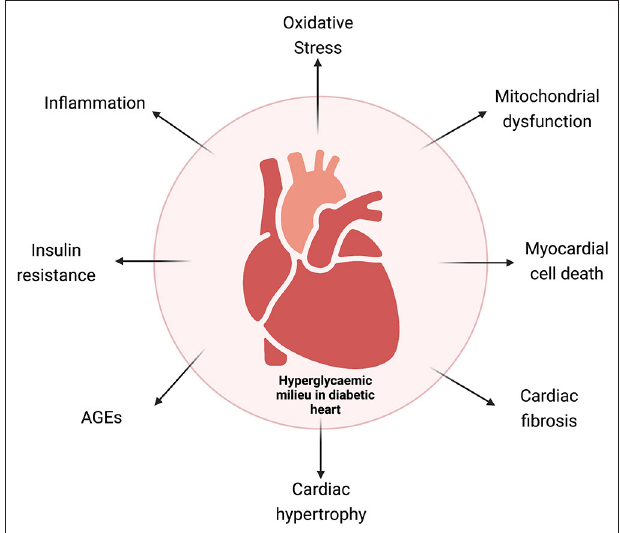
FIGURE 1 | Schematic representation of the various mechanisms involved in diabetic cardiomyopathy. AGEs, advanced glycation end products.